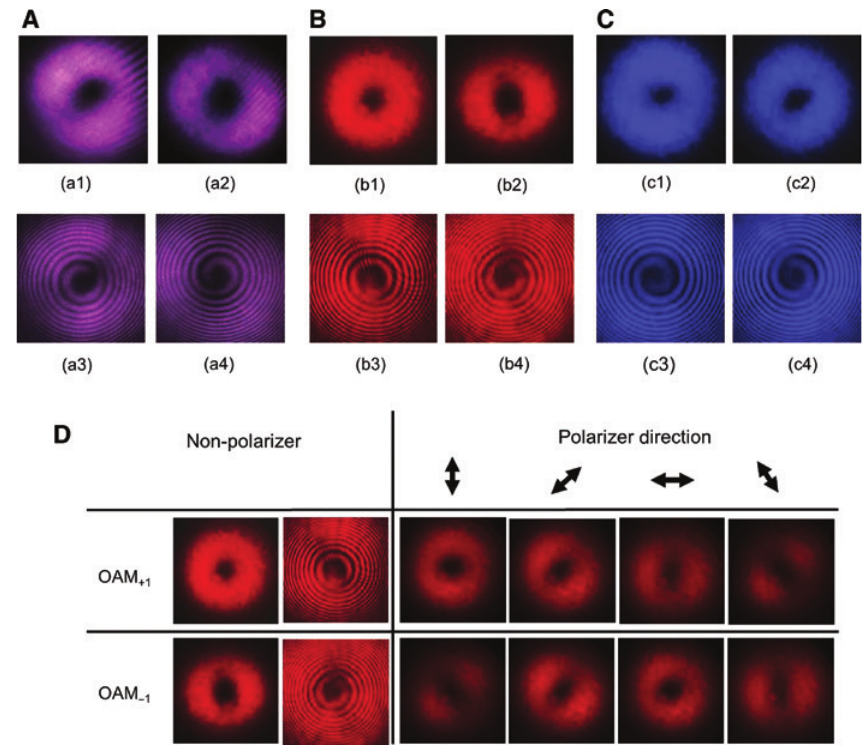
Figure 5: Near-field intensity distribution of vortex beams. The orbital angular momentums (OAMs) output by (A) 808, (B) 660, and (C) 450 nm mode selective couplers, the donut-shaped intensities (a1, a2), (b1, b2), (c1, c2) and their spiral interferences (a3, a4), (b3, b4), (c1, c2). (D) Near-field intensity distribution of 660 nm